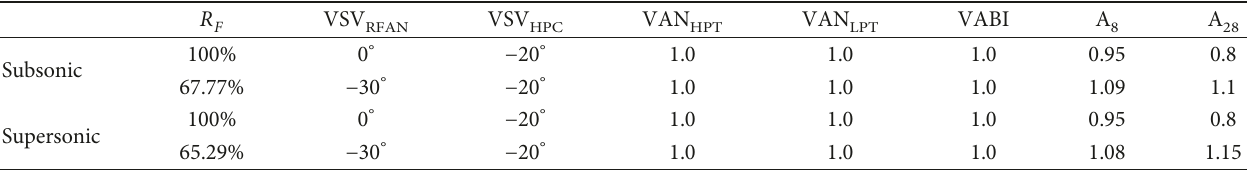
Table 6: Control schedule of variable geometries (group 2).